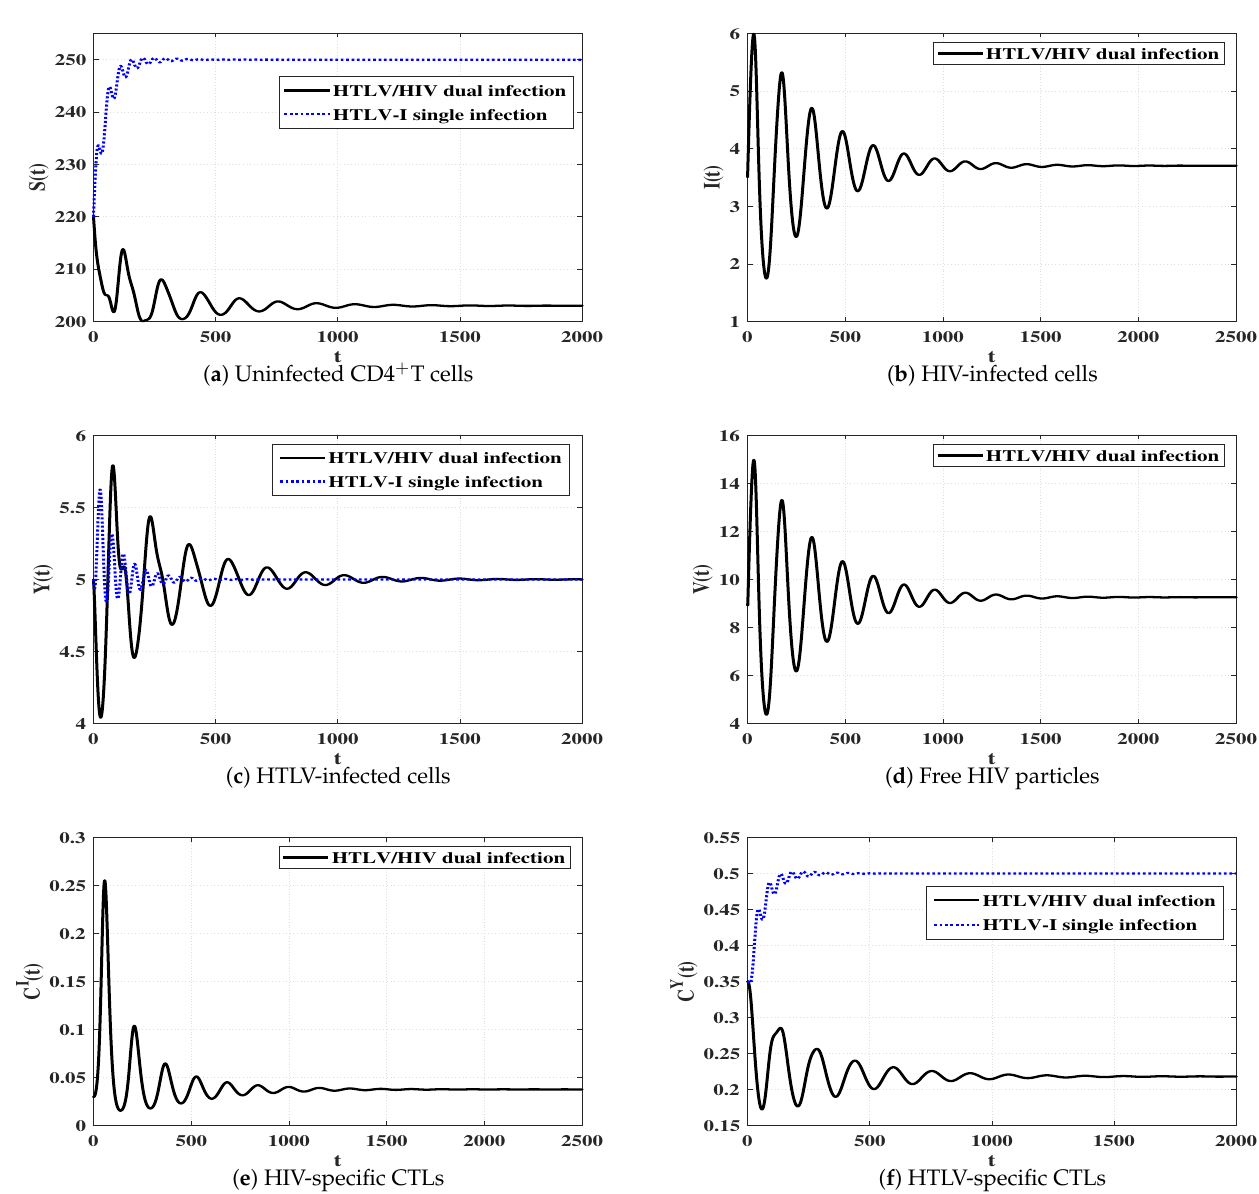
Figure 11. Comparison between the dynamics of HTLV-I single infection and HTLV/HIV dual